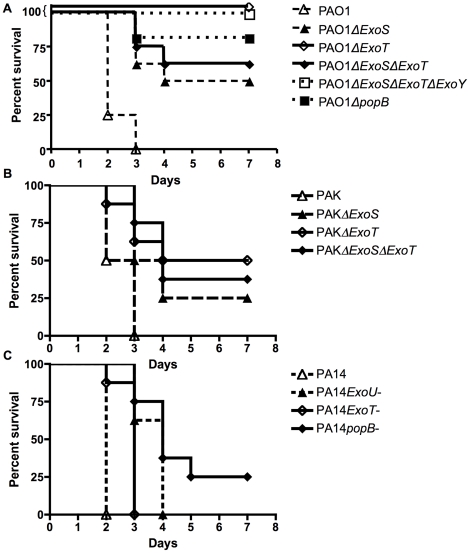
Survival curves of neutropenic mice colonized with wild-type P. aeruginosa and T3SS mutant strains.Female 6–8 wk-old C3H/HeN mice were colonized with P. aeruginosa strains PAO1(A), PAK (B), and PA14 (C) and with various deletional or insertional mutations of the type III secretion system in the corresponding WT background and then subsequently made neutropenic with monocloncal antibody RB6-8C5 (0.200 mg IP once). Median survival of mice colonized with mutants was significantly higher than that of mice colonized with the corresponding wildtype strain (P<0.009 for PAO1 mutants, P<0.009 for PAK mutants, P<0.006 for PA14 mutants, log-rank test). Each group contained 8 mice. T3SS, type III secretion system.